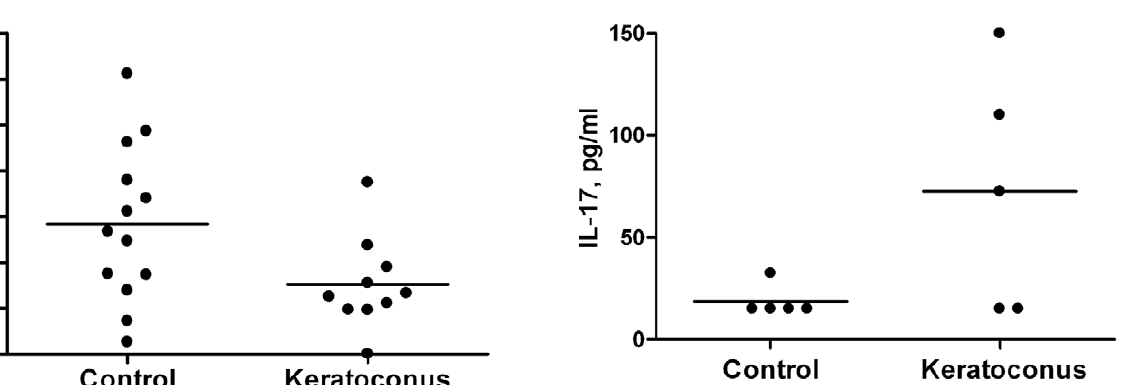
Figure 2. Decrease in IL-4 measured by standard ELISA. Samples shown in Table S2 were pooled into 13 control and 10 keratoconus samples (Methods). Each ELISA value is an average of two measure- ments. The decrease in IL-4 in the keratoconus pool (7.6 6 5 pg/ml), compared to controls (14.2 6 8.6 pg/ml) was statistically significant (p # 0.05, Mann-Whitney test). The horizontal bar indicates the mean value for each group.